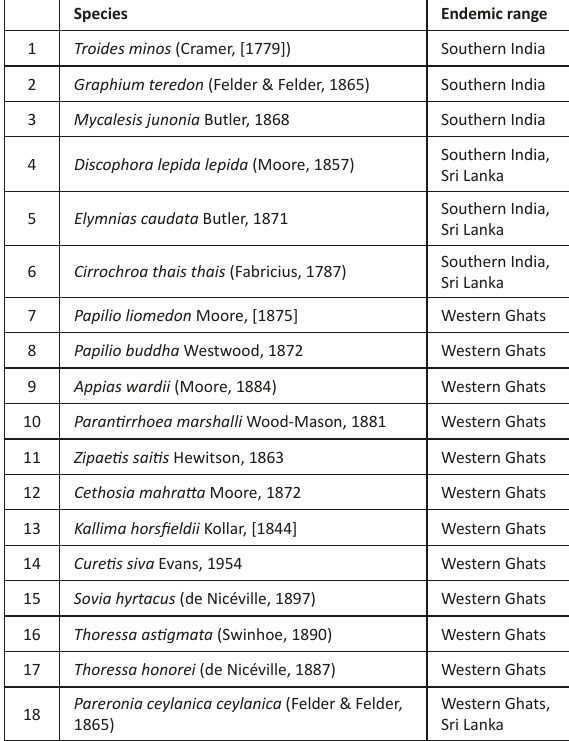
Table 2. Endemic species among myristica swamp associate butterflies